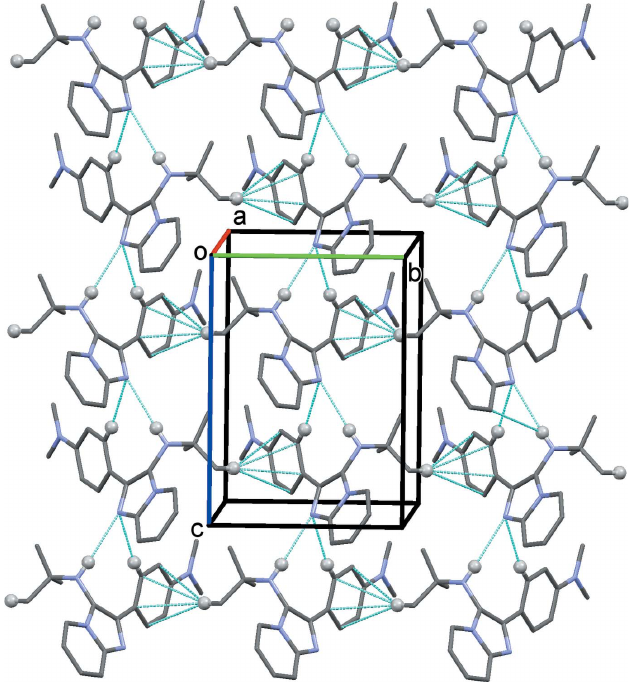
Figure 5 The crystal packing of compound (II) viewed along the a axis, showing the intermolecular N—H (cid:2)(cid:2)(cid:2) N and C—H (cid:2)(cid:2)(cid:2) N hydrogen bonds and C— H (cid:2)(cid:2)(cid:2) (cid:2) interactions as dashed lines (Table